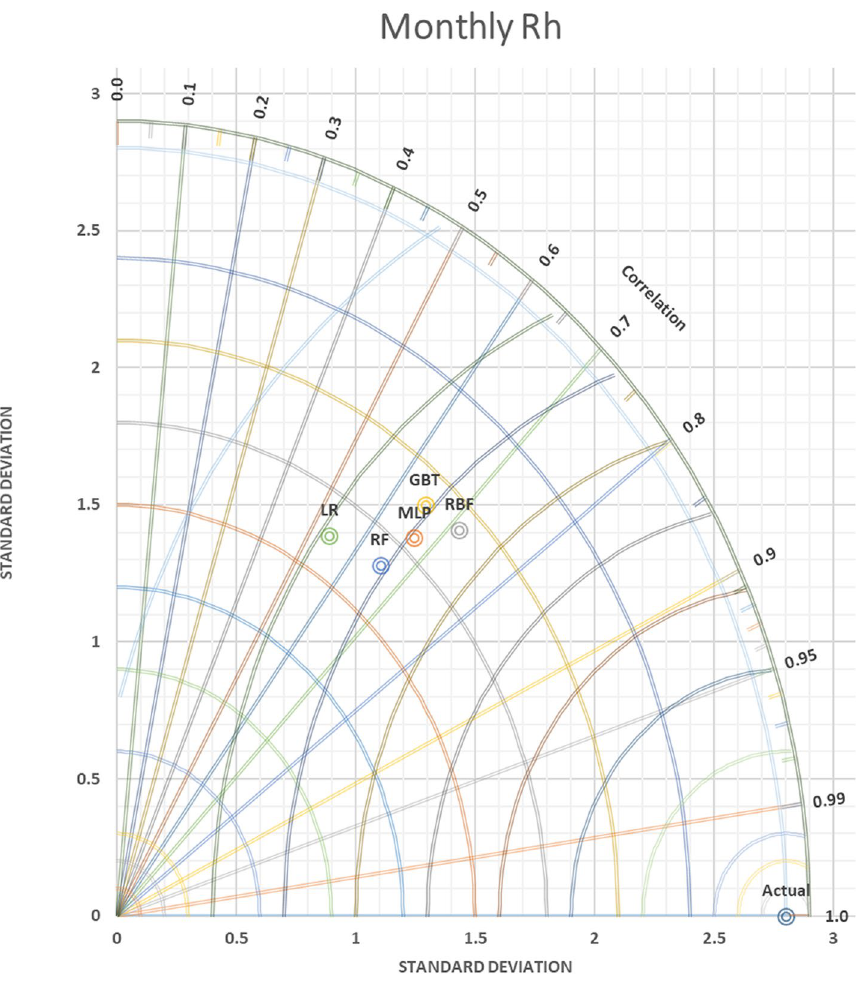
Figure 12. Taylor diagram of predicting monthly Rh percent using the most accurate models.